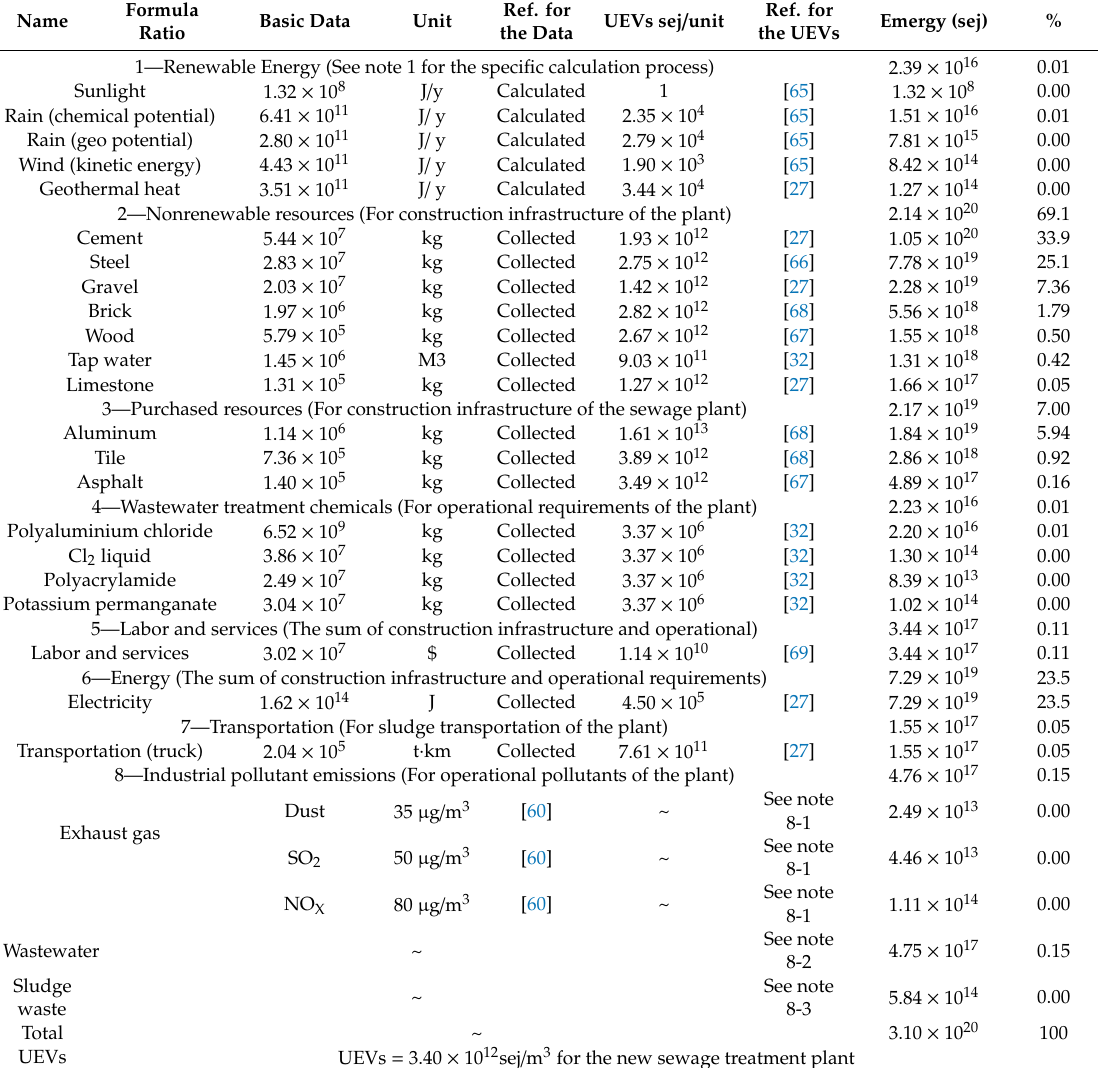
Table 10. Comprehensive emergy calculation form of the sewage treatment